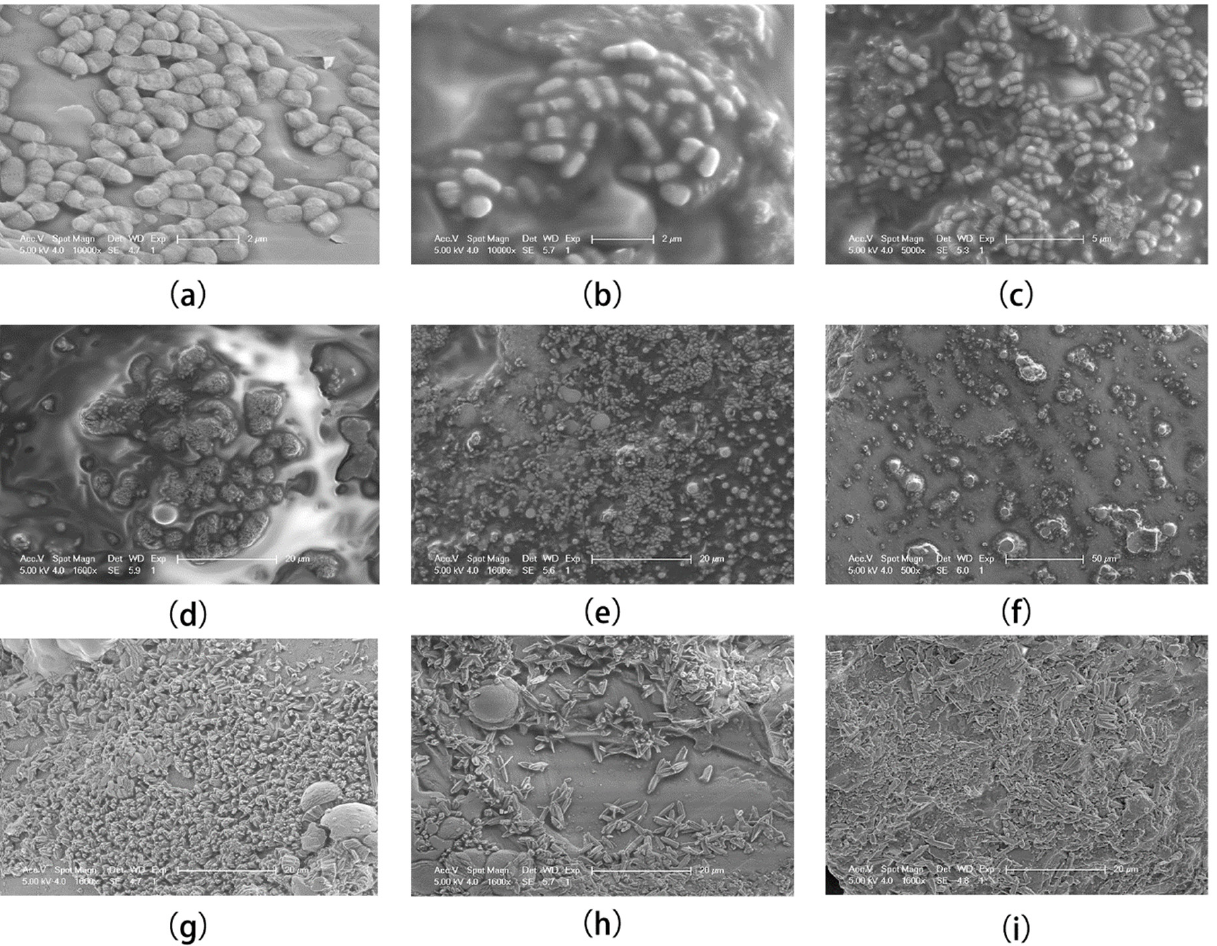
Figure 3. Morphology alterations of calcium carbonate crystals: ( a ) 2 h; ( b ) 4 h; ( c ) 6 h; ( d ) 12 h; ( e ) 24 h; ( f ) 48 h; ( g ) 72 h; ( h ) 120 h; and ( i ) 168 h.